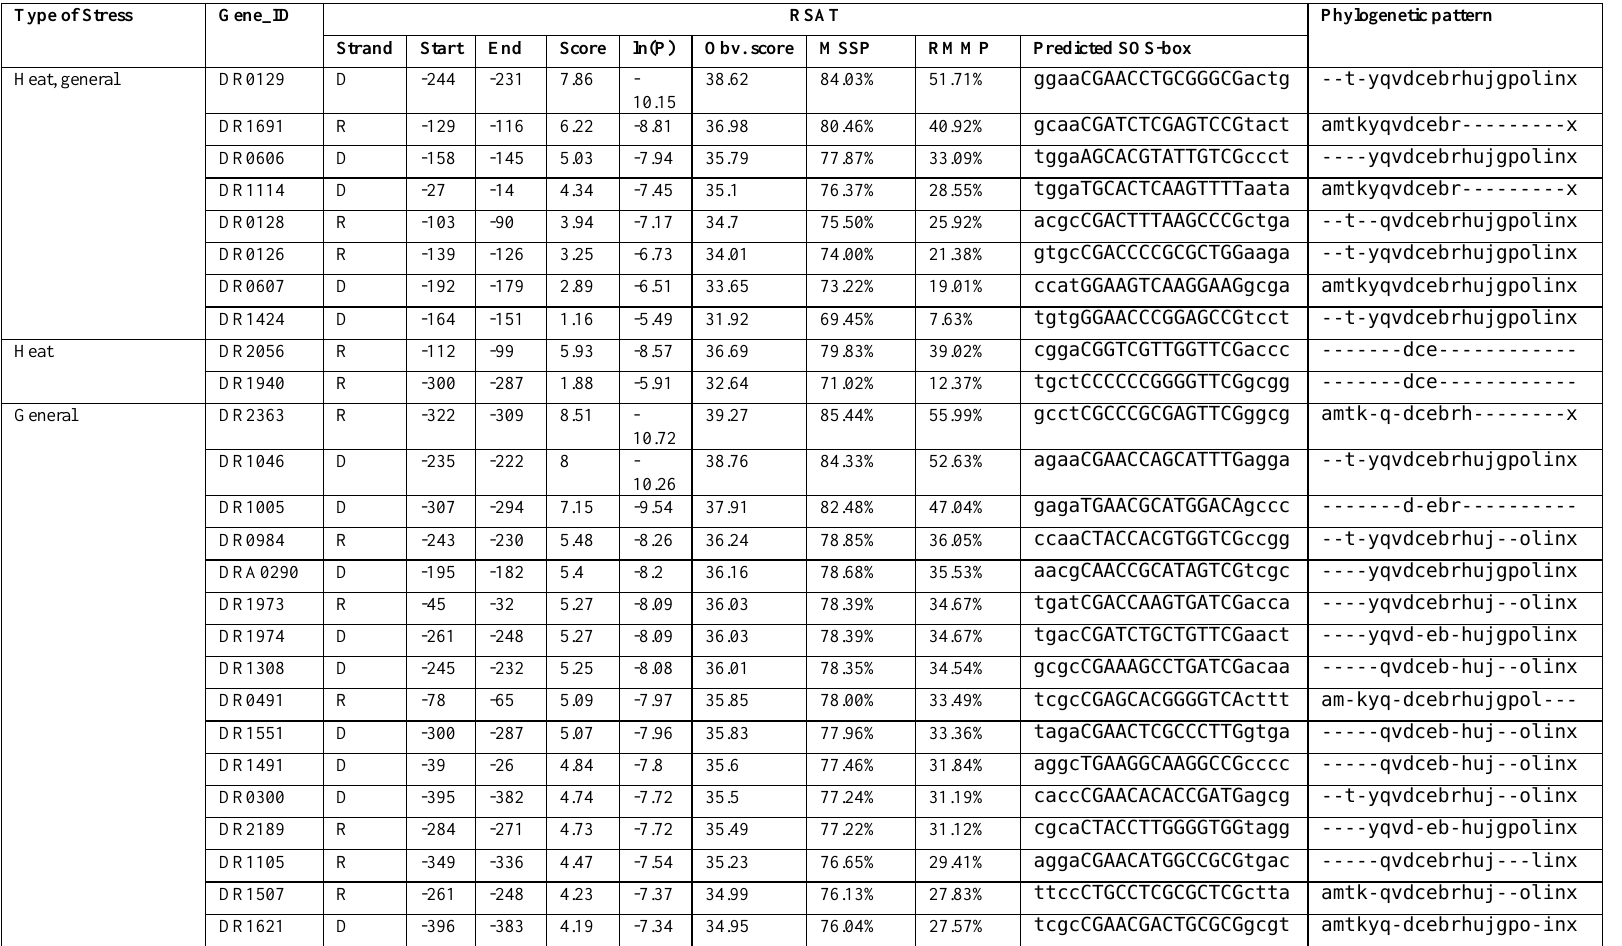
Supplementary Table 8 (S8): Details of SOS-box motifs predicted in the upstream sequences of D. radiodurans genes related to stress response through RSAT